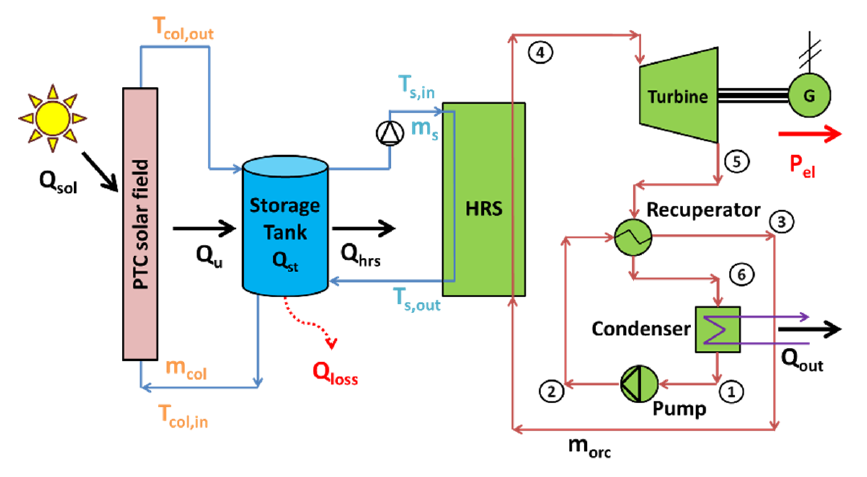
Figure 1. The examined solar-driven organic Rankine cycle (Parabolic trough solar collector (PTC), tank, organic Rankine cycle (ORC)).